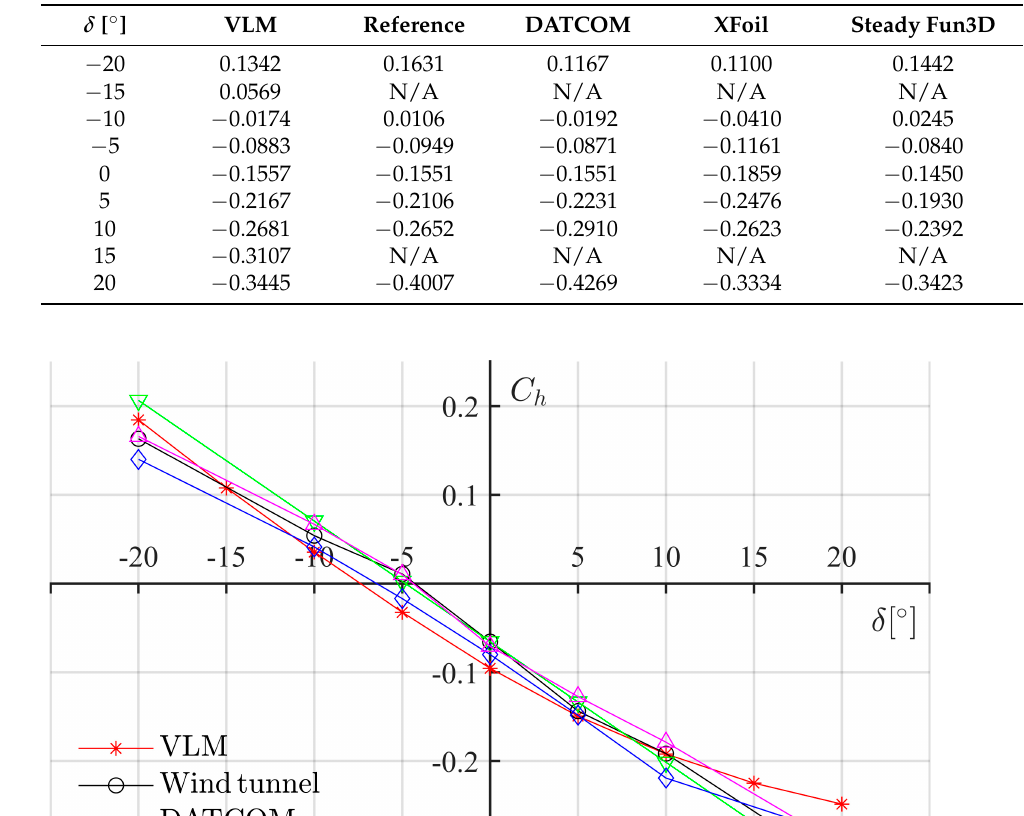
C for GA(W)-1 at alpha 0°. Table A6. Comparison of C h for GA(W)-1 at alpha 0 ◦ . h